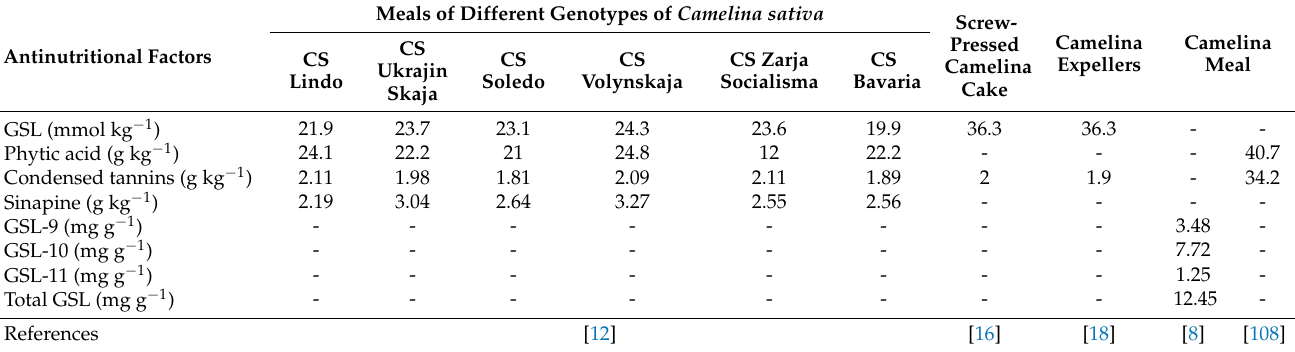
Table 6. Anti-nutritional factors of Camelina sativa cake, expeller, and meal. Meals of Different Genotypes of Camelina Antinutritional Factors